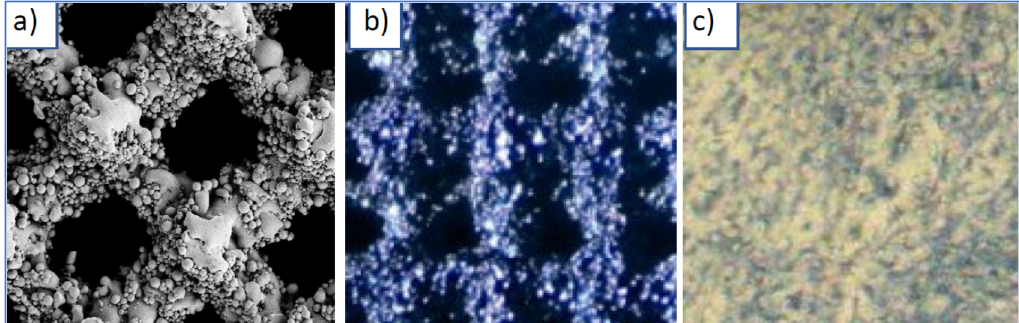
Figure 4. The structure of selectively sintered, at an angle of 45° relative to the x and y-axis of the working platform, ( a ) titanium—skeleton topography with a pore diameter ~350 µm after ultrasonic cleaning (SEM); ( b ) ultrasonically cleaned and chemically etched titanium to remove fine satellite powder particles and coated with Al 2 O 3 during 1500 cycles (SEM); ( c ) layers of cultured human cells from the hFOB 1.19 osteoblast culture line (Human ATCC-CRL-11372) American Type Culture Collection ATCC (USA) on the substrate of the porous alloy Ti6Al4V selectively sintered and coated with Al 2 O 3 by ALD (LM—fluorescent contrast).